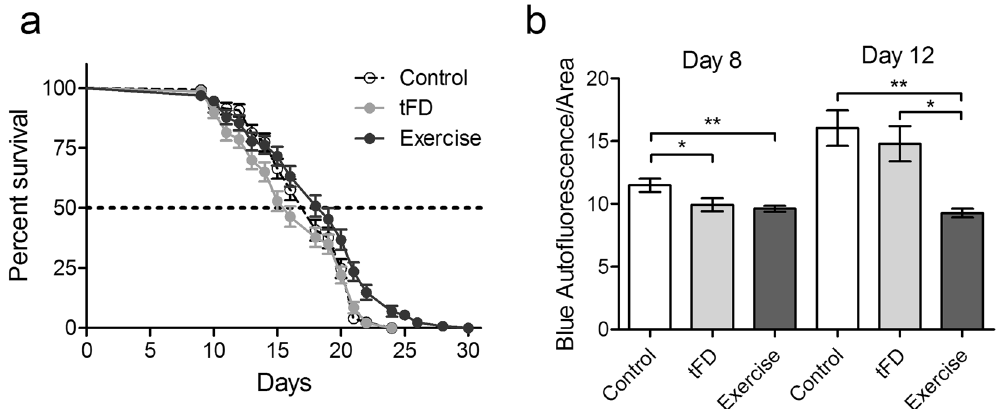
Figure 6. Exercise conditioning extends lifespan and reduces blue autofluorescence “death signal”. Panel a is the compiled lifespan data from three individual biological replicates of n = 50 animals each. For individual traces, see Supplementary Fig. S5. Panel b represents blue autofluorescence, normalized to worm area. Statistical significance was assessed by a one-way ANOVA followed by a Tukey posttest comparing all groups to each other. Autofluorescence data represents the mean and standard error from 3 biological replicates. Asterisks represent statistical significance: * p < 0.05; ** p <